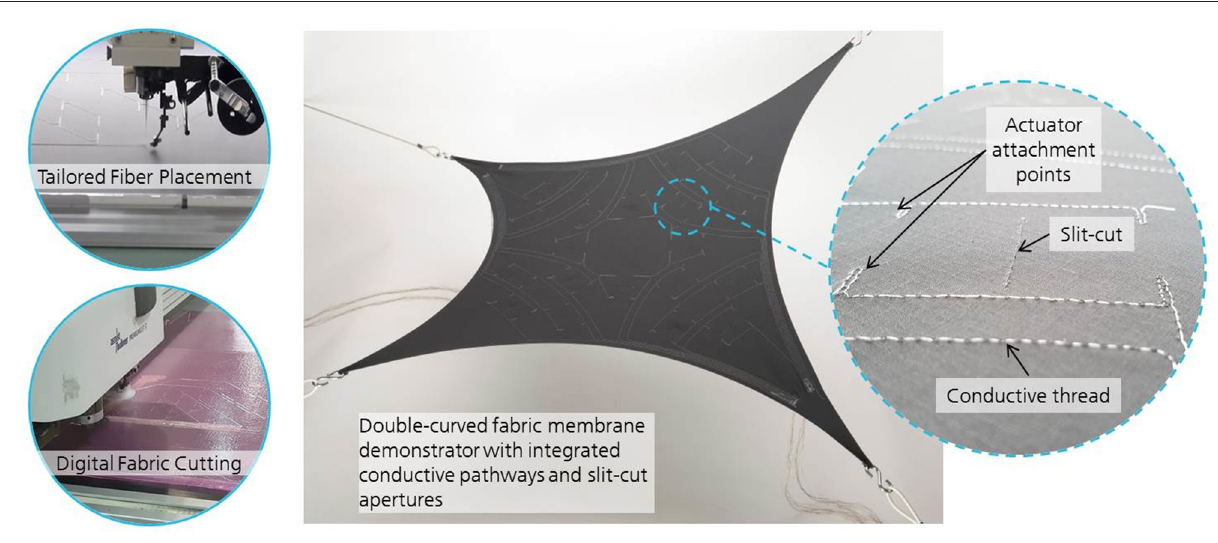
Frontiers in Built Environment |